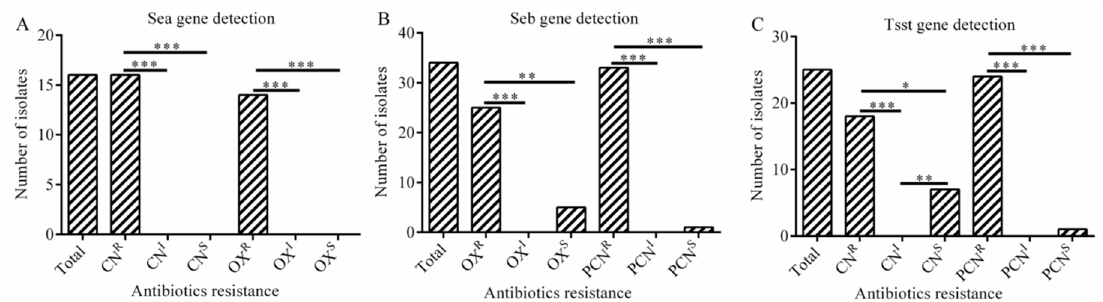
Figure 5. The association between virulence gene and antibiotic resistance ( A – C ) . ( A ) Correlation between sea gene and antibiotic resistance; ( B ) Correlation between seb gene and antibiotic resistance; ( C ) Correlation between tsst gene and antibiotic resistance. Statistics were achieved by independent sample test and ANOVA (*** p < 0.001, ** p < 0.01, * p < 0.05). CN R : resistance to gentamicin; CN I : intermediary to gentamicin; CN S : sensitive to gentamicin; OX R : resistance to oxacillin; OX I : intermediary to oxacillin; OX S : sensitive to oxacillin. PCN R : resistance to penicillin; PCN I : intermediary to penicillin; PNC S : sensitive to penicillin.